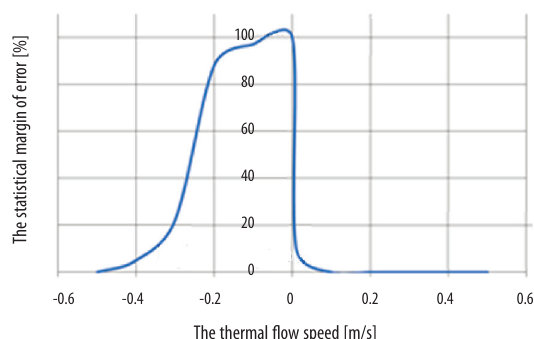
Fig. 7. Statistical margin of error detection of thermal flow when angle of attack is –0.5 degree